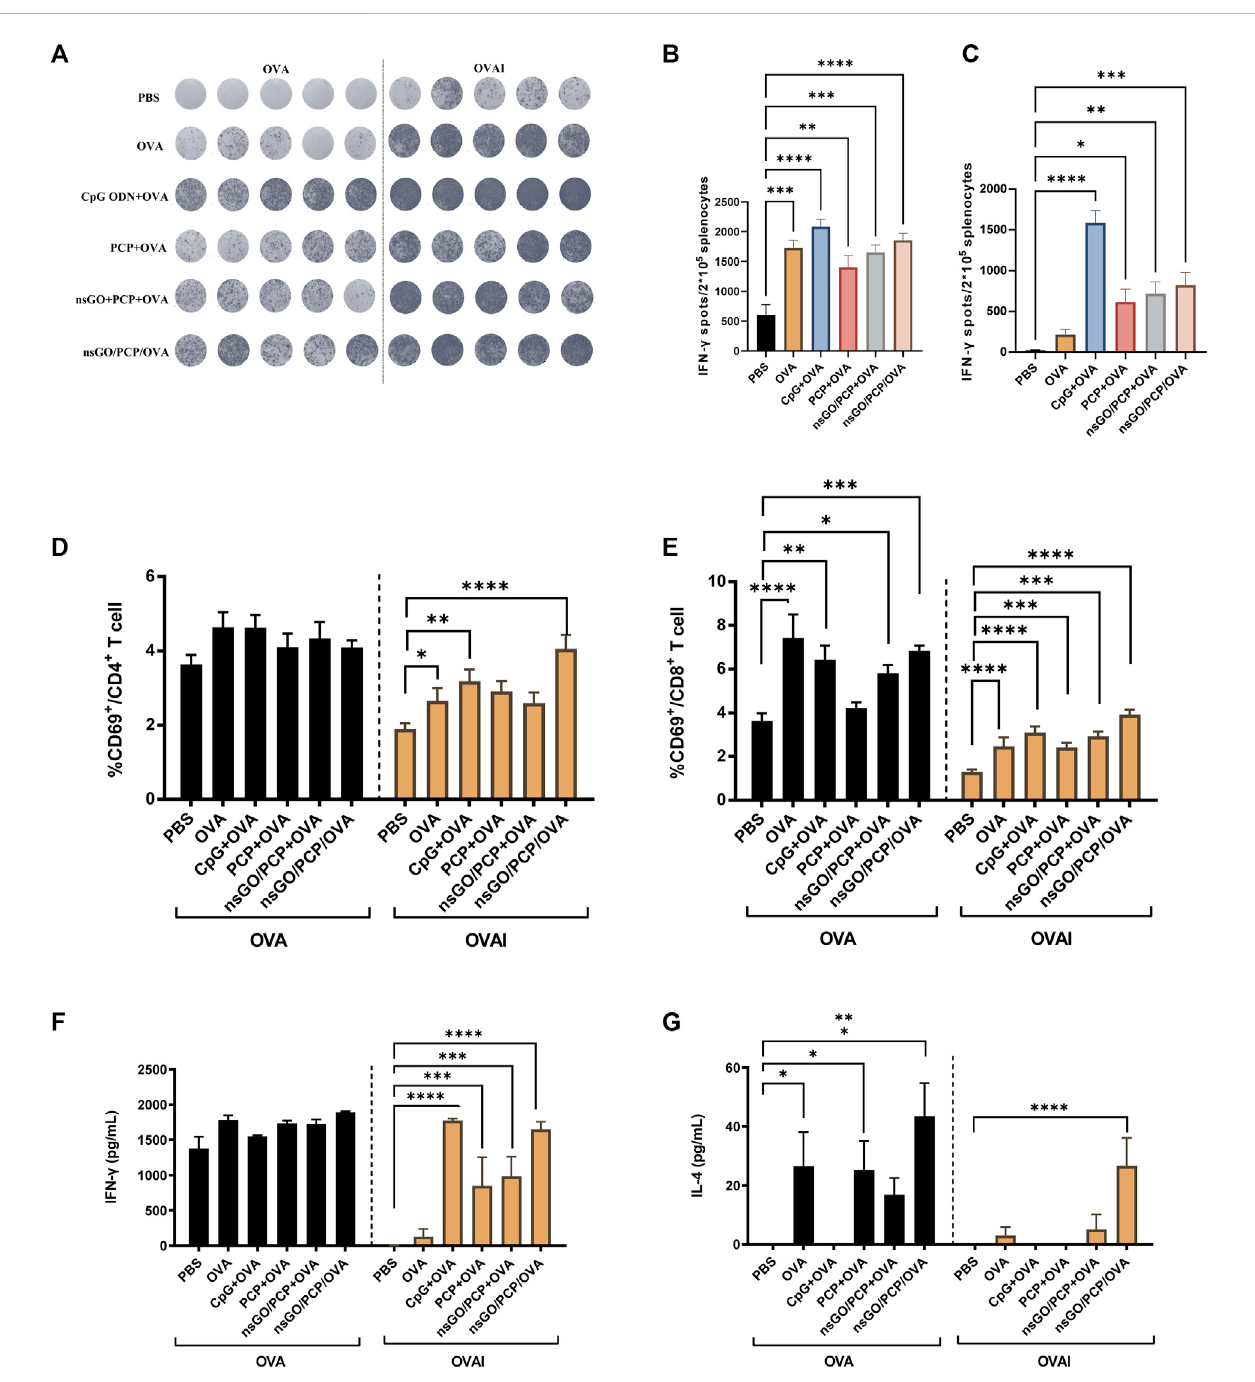
FIGURE 4 Stimulation of T cells in immunized mice by nsGO/PCP/OVA. Mice were immunized 3 times (s.c.) with PBS, OVA, PCP + OVA, CpG ODN + OVA, nsGO/ PCP + OVA or nsGO/PCP/OVA at 1 week intervals. Blood and spleen tissues were collected on day 21. (A) Splenocytes were stimulated with 300 μ g/mL OVA protein or 1 μ g/mL OVA peptide 257 – 264 (OVAI) per well. After 36 h, IFN- γ secreting cells were visualized and analyzed by ELISPOT. The number of OVA- stimulated (B) and OVA Ⅰ - (C) stimulated IFN- γ secreting cells was measured by ELISPOT. Splenocytes were co-cultured with OVA (300 μ g/mL) or OVA Ⅰ (1 μ g/mL) for 48 h, CD69 + CD4 + T (D) and CD69 + CD8 + T (E) cells were analyzed using FACS. Supernatants of splenocytes were collected at 72 h and measuredforIFN- γ (F) andIL-4 (G) levelsusingELISAkits.Dataarepresentedasmeans±SD(n=5),*, p < 0.05;**, p < 0.01;***, p < 0.001;****, p < 0.0001vs. PBS